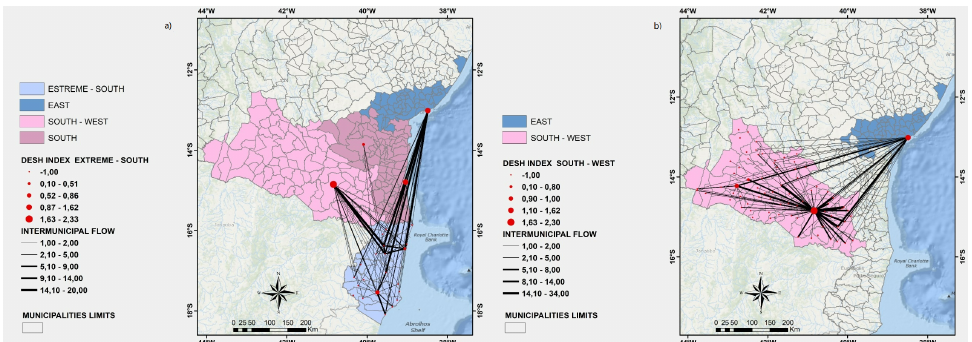
Figure 4. ( a ) A visualization of the Extreme-South, East, South-West, and South regions. ( b ) A visualization of the East and South-West regions. Source: Author.